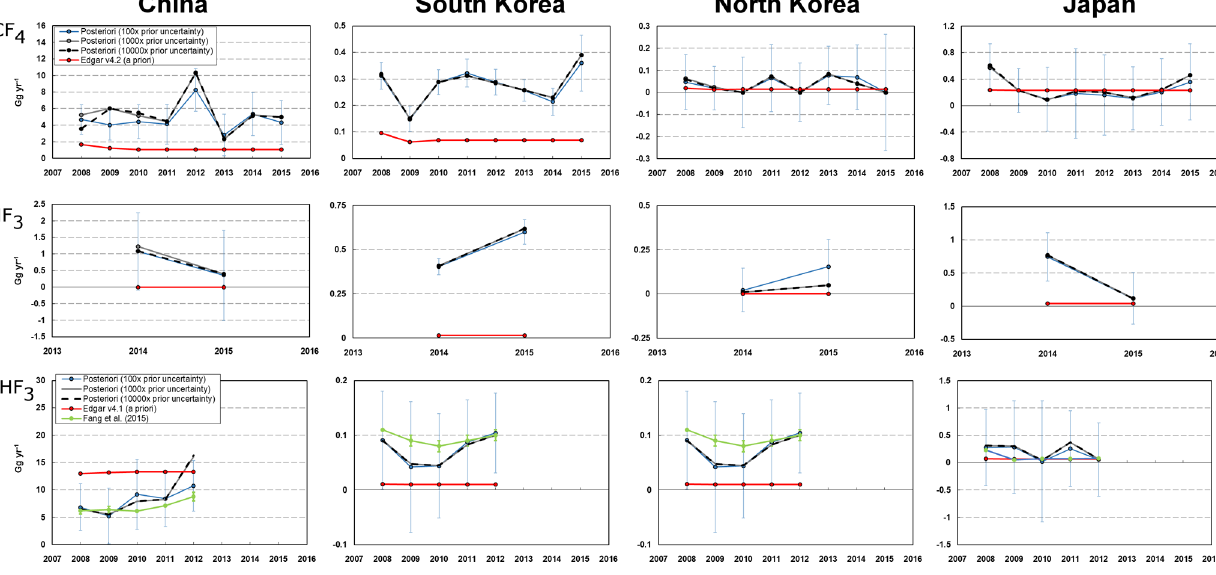
Figure 4. Time series of country emission totals (2008–2015). Annual inversion results are given for each gas for three different levels of uncertainty applied to the prior emission map: 100, 1000, and 10000 times the emission magnitude for each grid cell. The aggregated country totals from the prior data set are also given. Posterior uncertainties are shown for the 100 times prior uncertainty